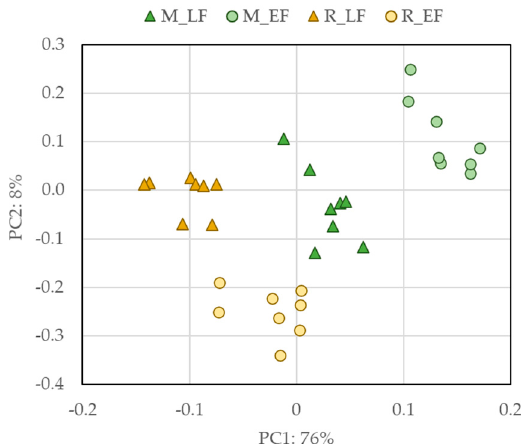
Figure 3. Score plot of the first two principal components of the PCA performed with FTIR-ATR spectra of Acacia flower samples using the first derivative Savitzky–Golay spectra transform with 17 smoothing points. M_LF— A. mearnsii late flower; M_EF— A. mearnsii early flower; R_LF—A. retinodes late flower; R_EF—A. r etinodes early flower.